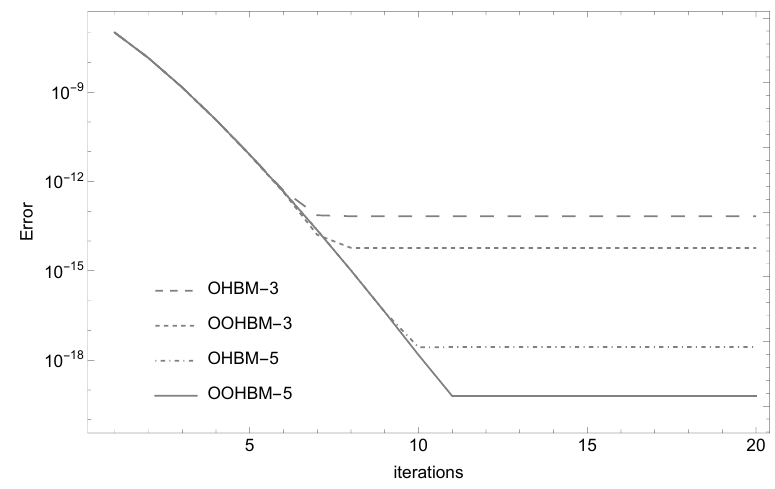
Figure 5. Comparison of the convergence plots for Example 2 when h = 0.1.